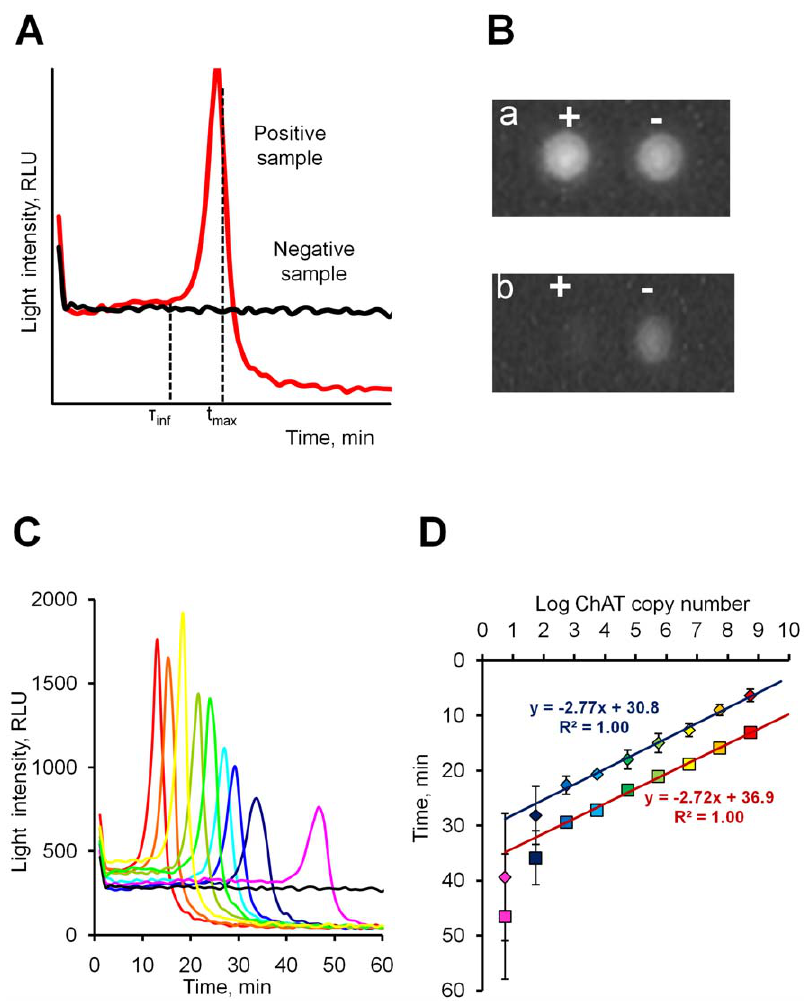
Figure 2. Qualitative and quantitative BART. (A) Typical BART curve (raw experimental data) for a positive sample (red) shows characteristic time to first inflexion point ( t inf ) and time to peak (t max ); the curve for a negative sample (black) gradually decays. (B) Images of a positive ( + ) and a negative ( 2 ) samples at the beginning (a) and at the end (b) of the BART assay. (C) Real-time bioluminescent assay of ChAT DNA dilution series amplified by LAMP at 55 u C for 1 hour (raw experimental data). 5.5 6 10 8 copies – red, 5.5 6 10 7 – orange, 5.5 6 10 6 – yellow, 5.5 6 10 5 – light-green, 5.5 6 10 4 – dark-green, 5.5 6 10 3 – light-blue, 5.5 6 10 2 – dark-blue, 55 – violet, 5.5 – pink, NTC - black. Each curve represents one of three replicates for 5.5 6 10 3 –5.5 6 10 8 copies and one of six replicates for 5.5–5.5 6 10 2 measured with or without salmon sperm DNA (100 ng total). (D) Semi-logarithmic plot of the time to first inflexion point ( t inf - blue line) and time to peak (t max – brown line) versus ChAT DNA copy number in the LAMP-BART reactions of which representative curves are shown in (C). Bars show standard deviation. Note that all samples are averaged here, both containing 100 ng carrier DNA or without it.